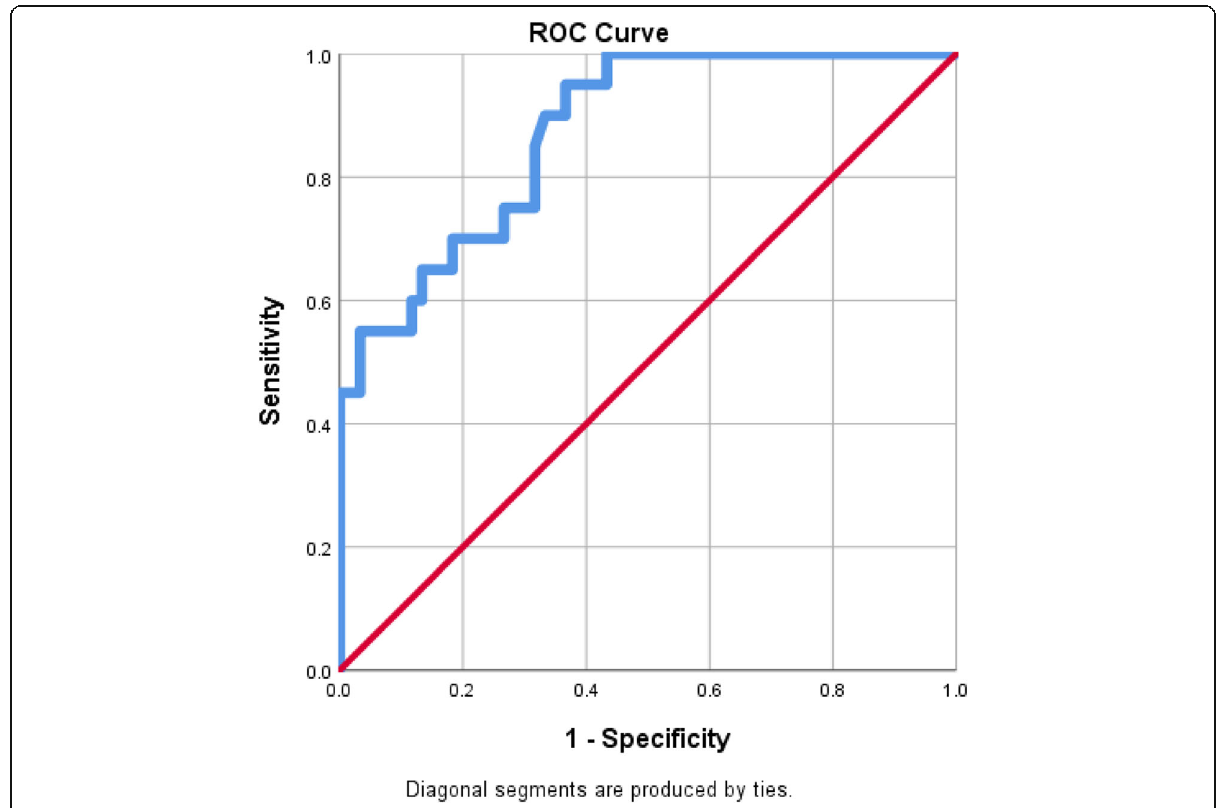
Fig. 4 The results of ROC curve analysis of DKK-1 in the studied active lupus nephritis and normal